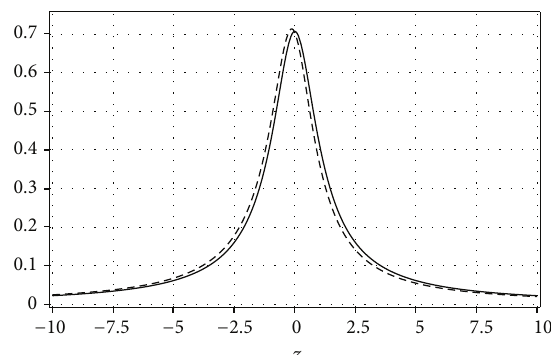
Figure 8: Plot of the normalized graviton zero mode 𝜓 0 (𝑧) , for 𝑐 = 0 (solid line) and for 𝑐 = 1/5 (long dashed